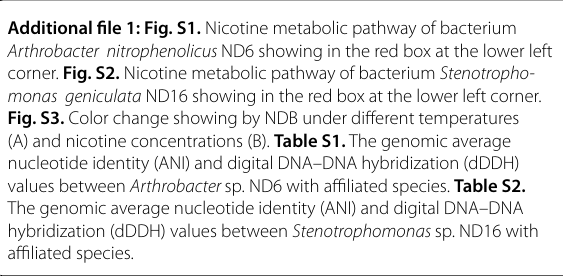
Fig. S3. Color change showing by NDB under different temperatures (A) and nicotine concentrations (B). Table S1. The genomic average nucleotide identity (ANI) and digital DNA–DNA hybridization (dDDH) values between Arthrobacter sp. ND6 with affiliated species. Table S2. The genomic average nucleotide identity (ANI) and digital DNA–DNA hybridization (dDDH) values between Stenotrophomonas sp. ND16 with affiliated